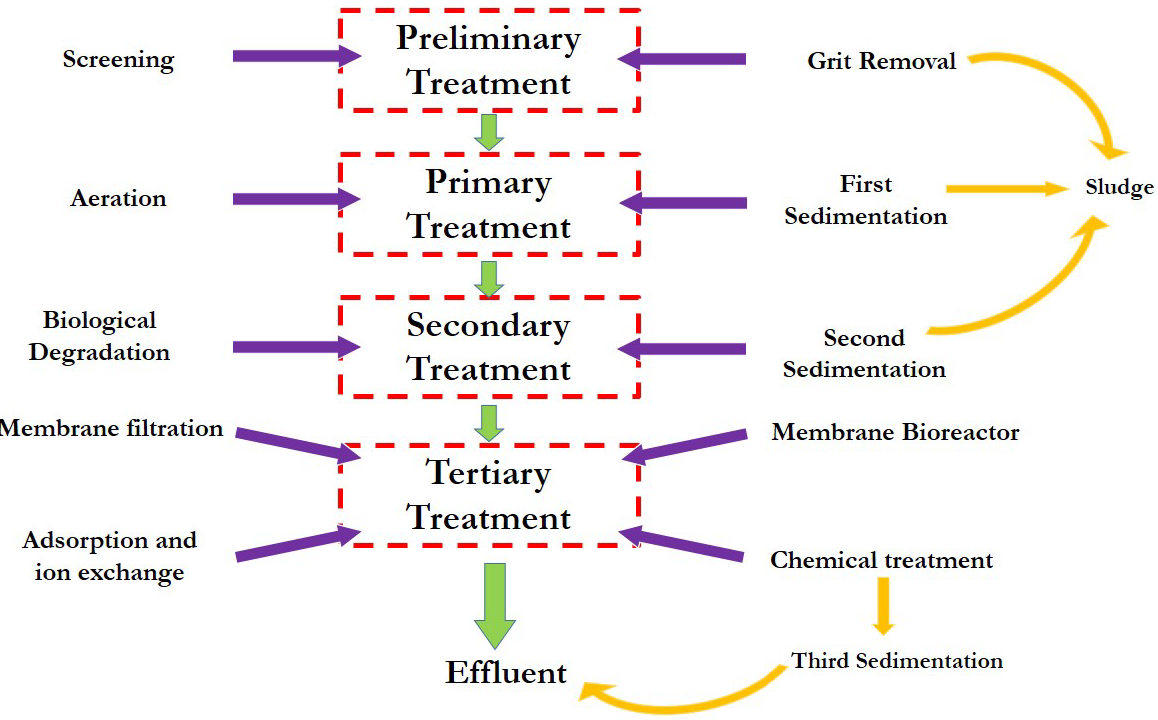
Figure 6. Schematic representation of methods and stages in wastewater